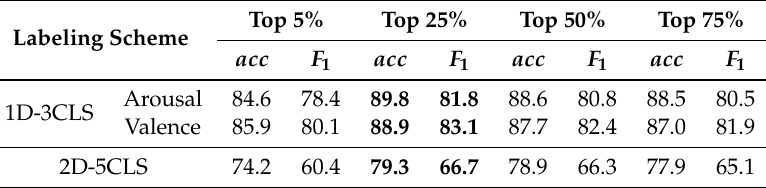
Table 10. The results of the feature-based evaluation analysis computed for the 1D-3CLS and 2D-5CLS after excluding the feature vectors that correspond to the neutral class. Bold font is used to indicate the highest acc and F 1 values obtained for each EEG channel